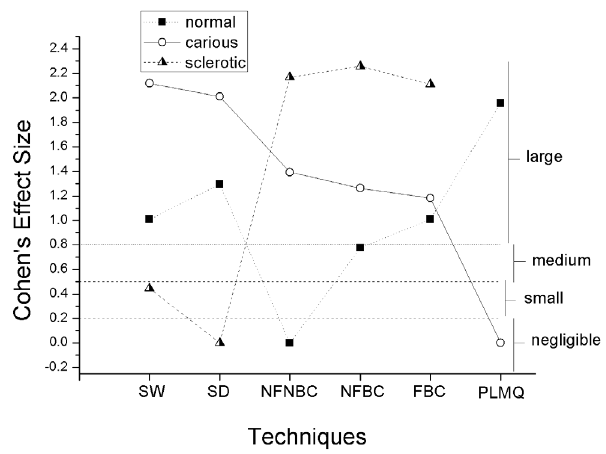
Figure 2. Effect sizes of comparisons between the “temporary gold standard” and other techniques on the detection of normal (black square + dashed line), carious (open circle + continuous line), and sclerotic (half-filled triangles + short dashed line) dentin. Labels on the right are magnitudes of effect size in relation to the “temporary gold standard”